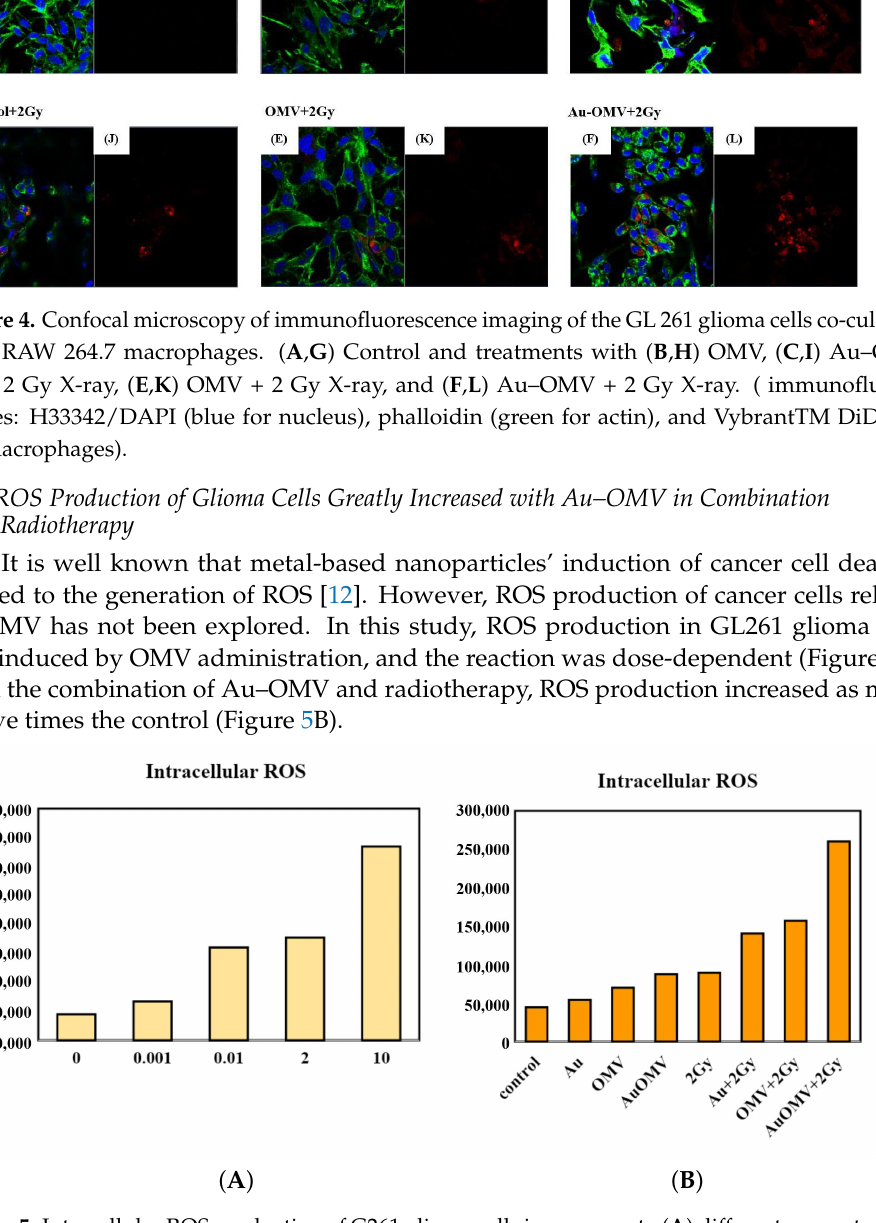
Figure 5. Intracellular ROS production of G261 glioma cells in response to ( A ) different concentrations of OMV and ( B ) various